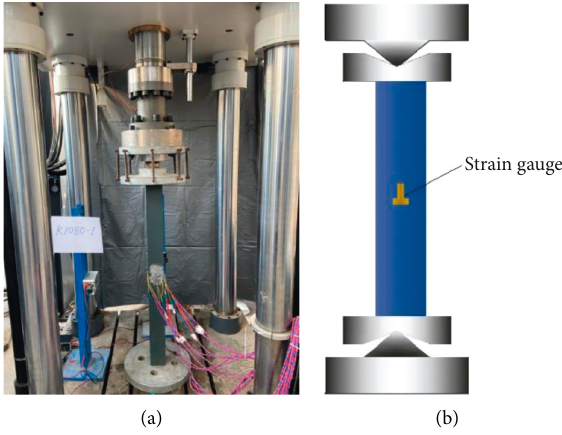
Figure 3: Test setup and layout of strain gauges.